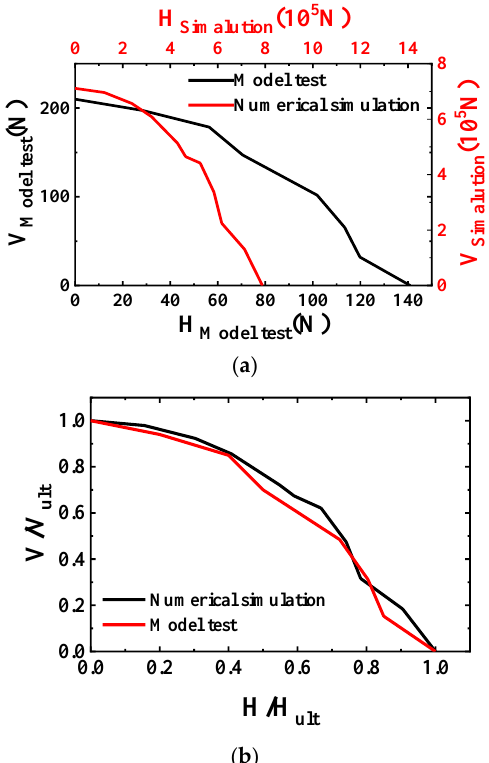
Figure 22. V-H failure envelope of gravity anchor. ( a ) The V-H envelope of the model test and numerical simulation. ( b ) Normalized V-H failure envelopes.